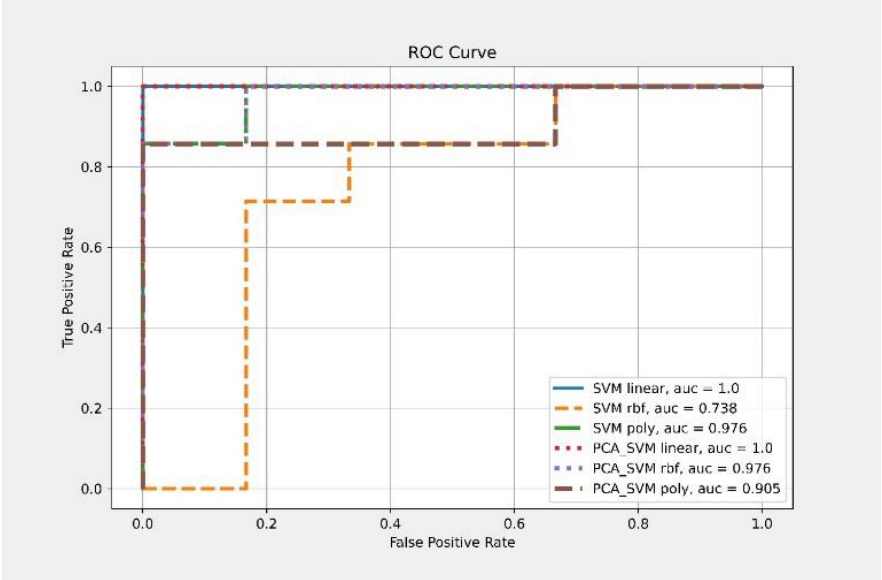
Figure 3. ROC curve and AUC result for each 13-parameter classifier of CDR-SB deterioration.